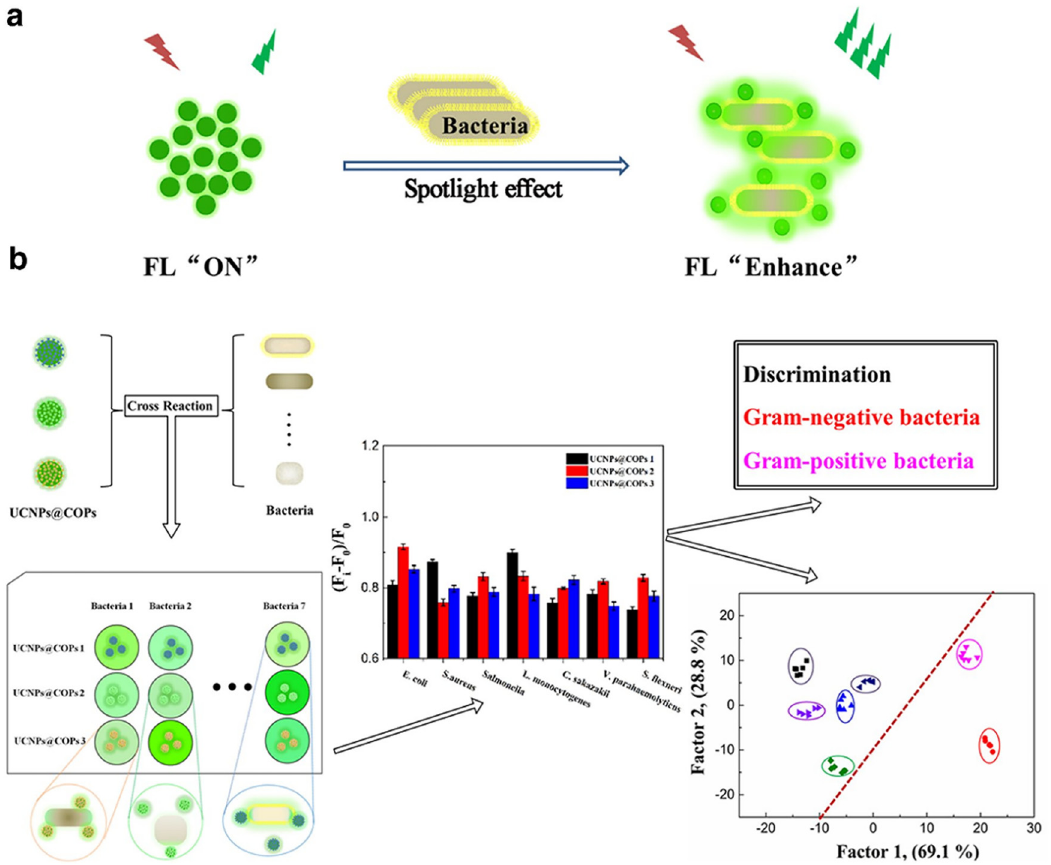
Figure 3: Based on UCNPs@COPs bacterial pattern recognition of material fl uorescent sensor array; ( a ) the principle of fl uorescence emission intensity enhancement of UCNPs materials and ( b ) schematic diagram of sensor array and the obtained fl uorescence response pattern are used to identify and classify bacteria by linear discriminant method [ 111 ]